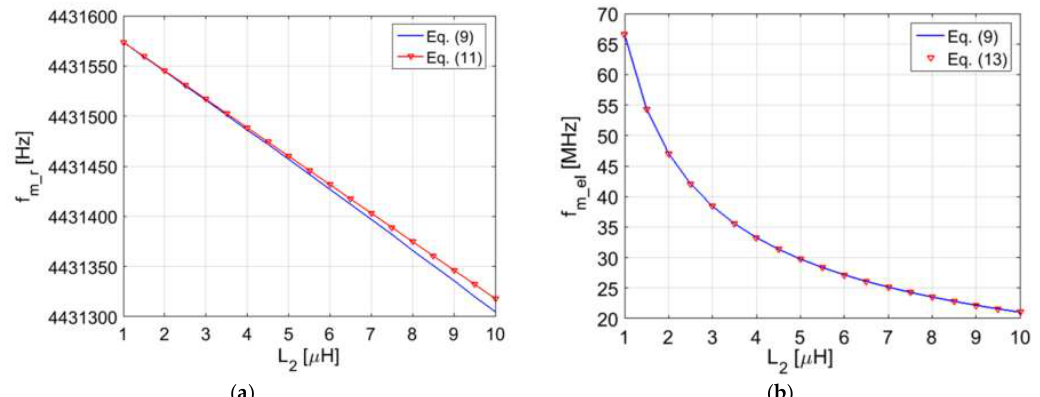
Figure 8. ( a ) Comparison of f m_r derived from the maximum of Re{ Z 1 } for frequencies around f r , in Equation (9), and the approximate value from Equation (11) as a function of L 2 ; ( b ) comparison of f m_el derived from the maximum of Re{ Z 1 } for f >> f r , in Equation (9), and the approximate value from Equation (13) as a function of L 2 .